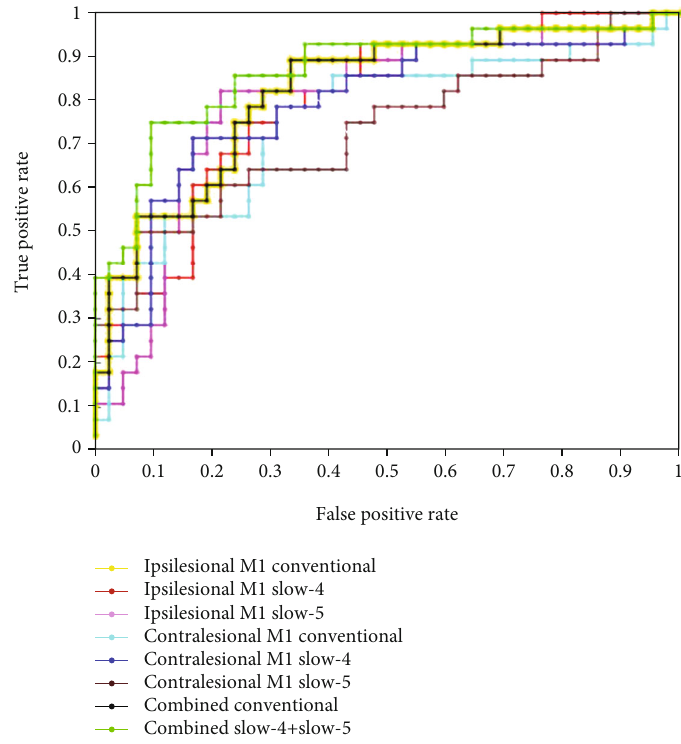
Figure 3: The receiver operating characteristic (ROC) curve in di ff erent features. The yellow line with a dot represents the ROC curve of the features in ipsilesional M1 in the conventional frequency band. The red line with a dot represents the ROC curve of the features in ipsilesional M1 in slow-4. The pink line with a dot represents the ROC curve of the features in ipsilesional M1 in slow-5. The cyan line with a dot represents the ROC curve of the features in contralesional M1 in the conventional frequency band. The blue line with a dot represents the ROC curve of the features in contralesional M1in slow-4. The brown line with a dot represents the ROC curve of the features in contralesional M1 in slow-5. The black line with a dot represents the ROC curve of the combined features in the conventional frequency band. The green line with a dot represents the ROC curve of the combined features in subfrequency bands